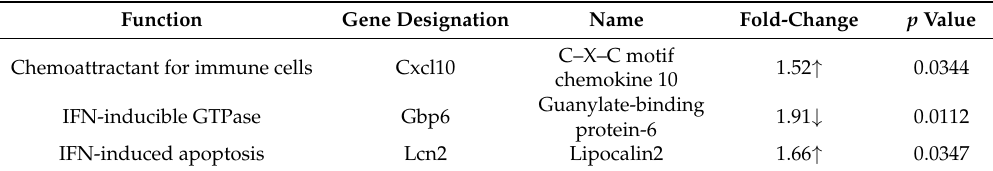
Table 4. Genes associated with IFN signaling are altered in the mouse spinal cord slice cultures infected with